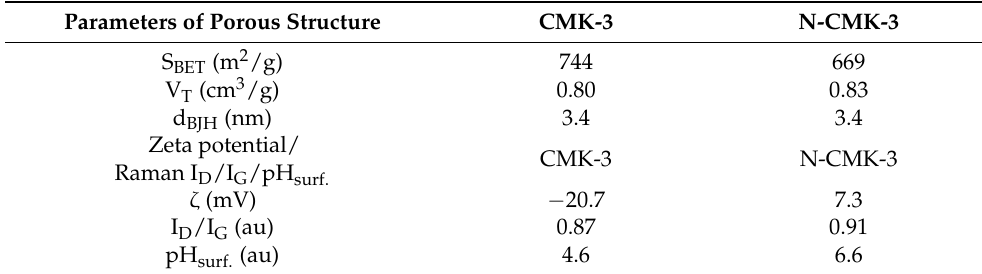
Table 1. Parameters of the porous structure (S BET , V T and d BJH ) obtained from nitrogen isotherms, zeta potential, Raman I D /I G and pH surf. values for both studied